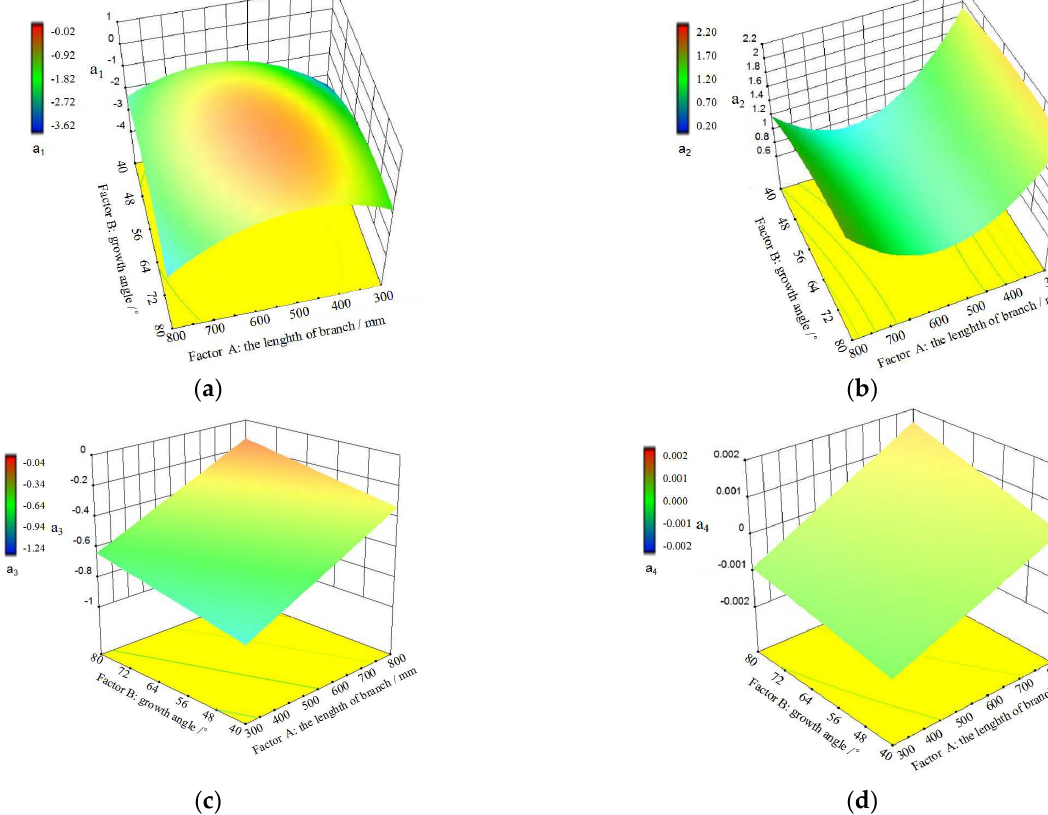
Figure 8. Response surface of various parameters of the cubic morphological equation to each factor: ( a ) effects of branch length and growth angle on parameter a1; ( b ) effects of branch length and growth angle on parameter a2; ( c ) effects of branch length and growth angle on parameter a3; ( d ) effects of branch length and growth angle on parameter a4.